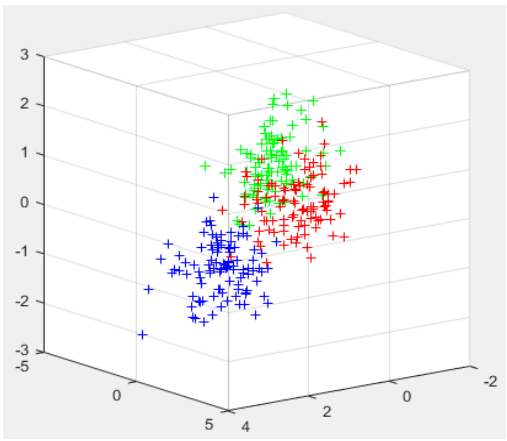
Figure 5. Matlab clustering results with K-means results.